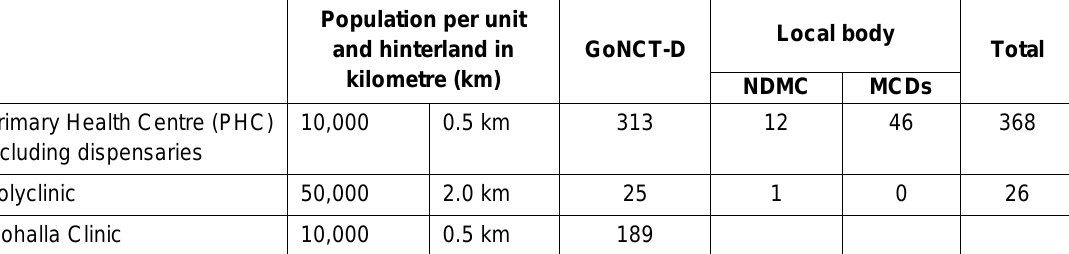
Table 2: Public (primary) health facilities in Delhi, by size of population served and provider, as at